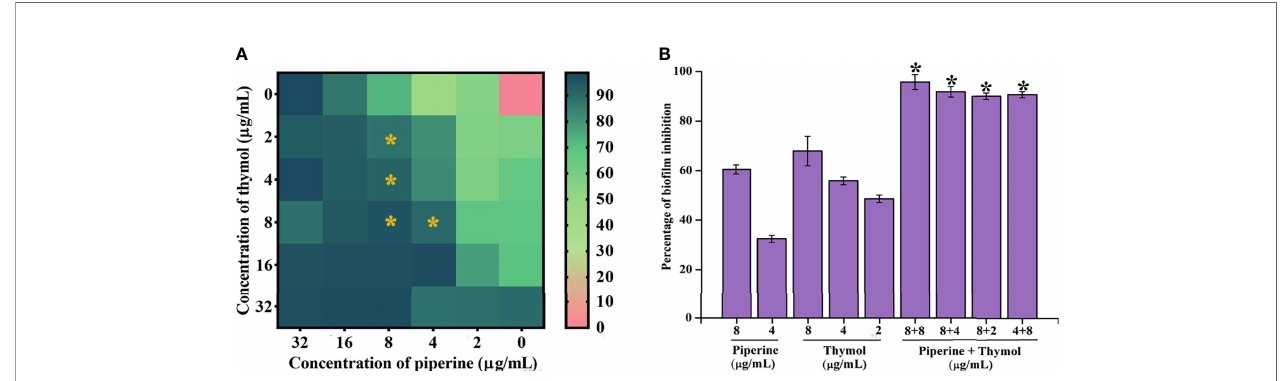
FIGURE 2 | Synergistic antibio fi lm ef fi cacy of piperine and thymol against C . albicans . (A) Interaction of piperine and thymol in exhibiting antibio fi lm ef fi cacy was appraised through checkerboard analysis. Heatmap displays the percentage of bio fi lm inhibition by various combinations of piperine and thymol. Four different synergistic antibio fi lm combinations of piperine and thymol were identi fi ed — 8 + 8, 8 + 4, 8 + 2, and 4 + 8 µg/ml. (B) Comparative analysis of individual and combinatorial ef fi cacy of piperine and thymol at synergistic combination concentrations against bio fi lm of C . albicans . Error bars represent standard deviations from the mean, and * indicates signi fi cance p <